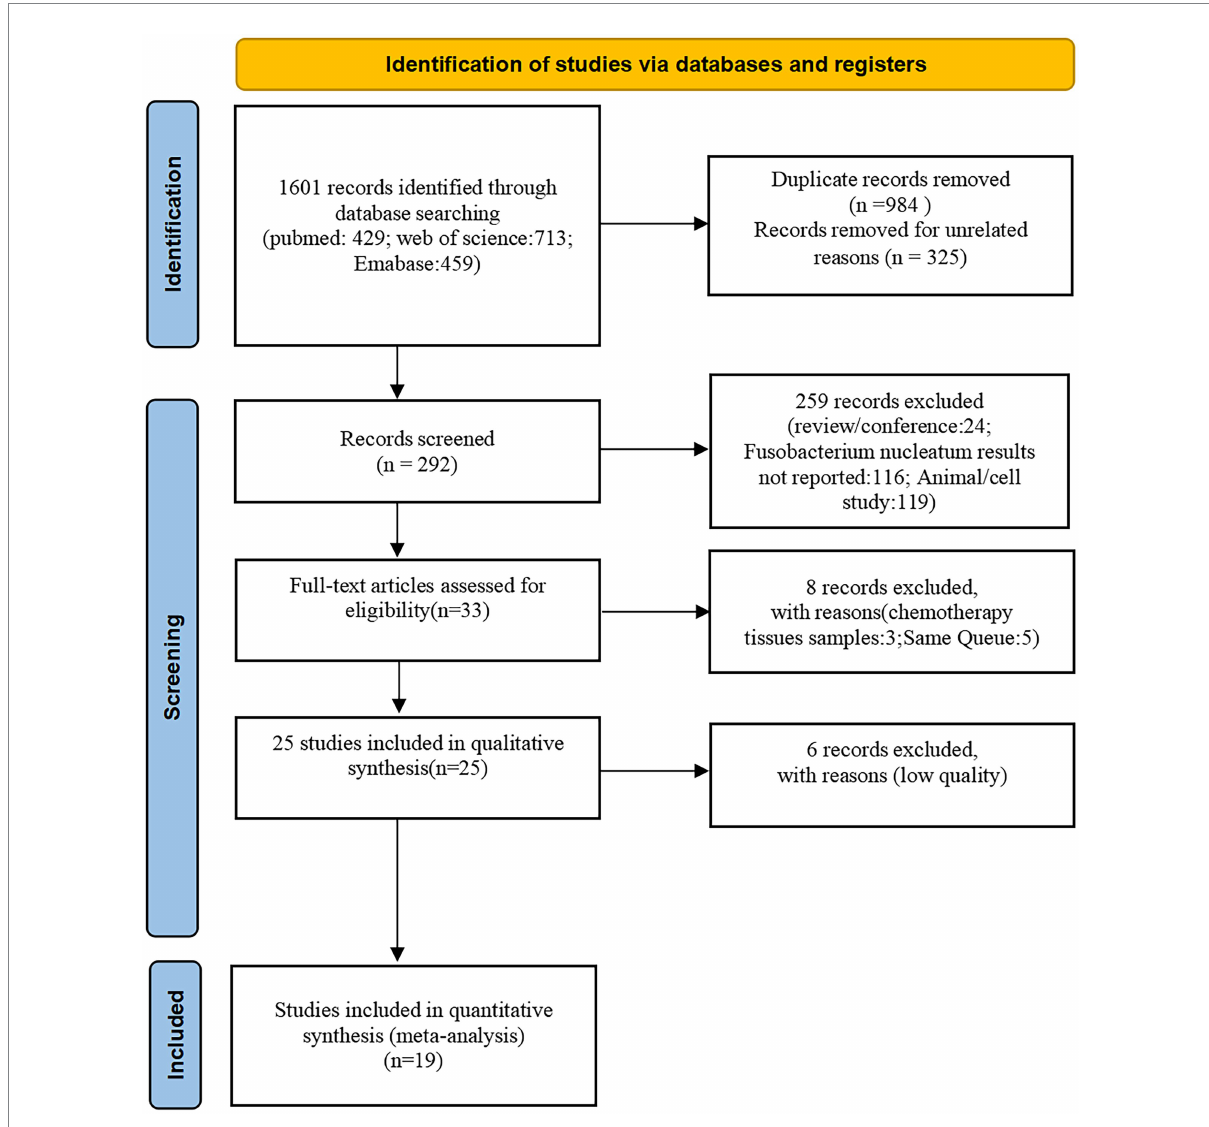
FIGURE 1 Study selection. A total of 19 eligible studies were included from 1,601 potentially relevant studies identified and